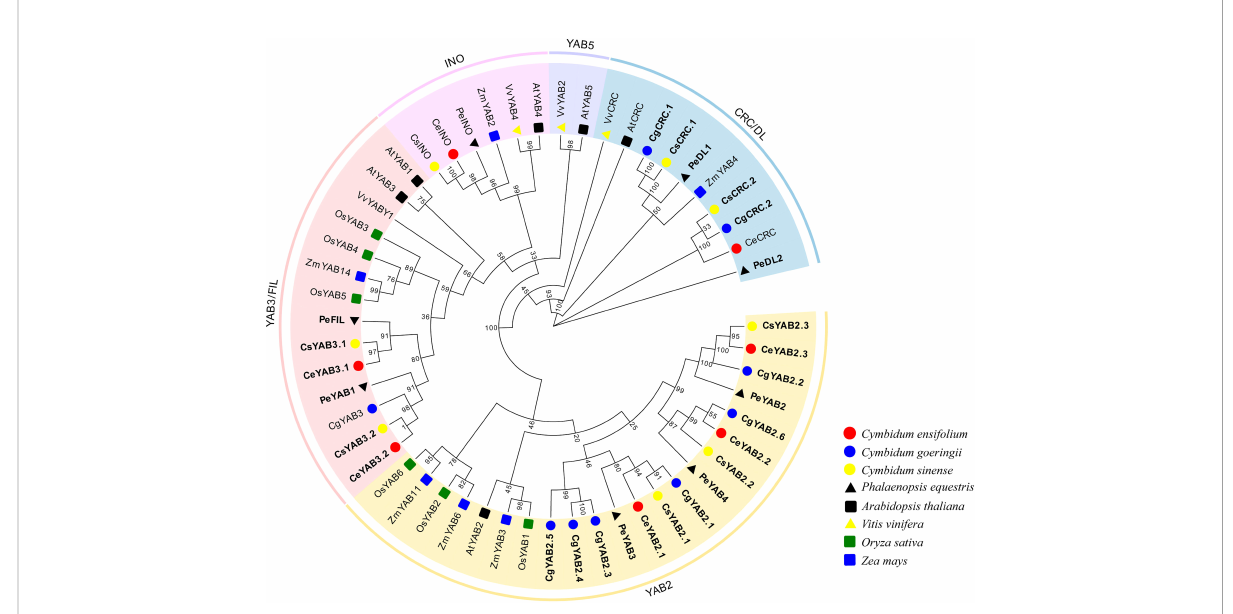
FIGURE 1 Phylogenetic tree of YABBY genes in eight plant species. The phylogenetic tree was created with the maximum-likelihood (ML) method using RAxML on the CIPRES Science Gateway web server (RAxML-HPC2 on XSEDE; Miller et al., 2011). Bootstrap values based on 1000 replicates are shown along the branches. Ce, C. ensifolium ; Cg, C. goeringii ; Cs, C. sinensis ; At, A. thaliana ; Os, O. sativa ; Pe, P. equestris ; Vv, V. vinifera ; Zm, Z. mays ; The duplicated genes are shown in